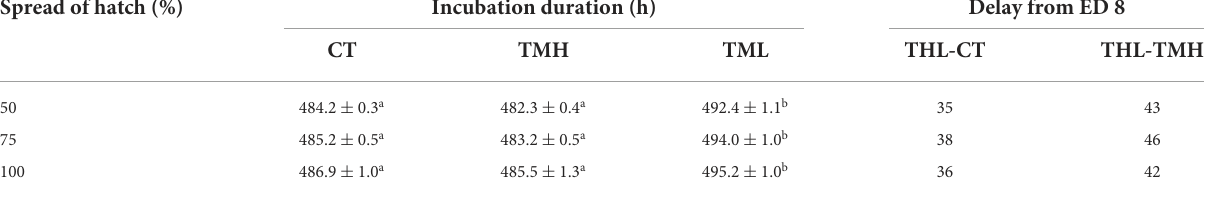
TABLE 2 Incubation duration and calculated time delay (min/d) of hatching after exposure to control or modified temperature during embryogenesis. Spread of hatch